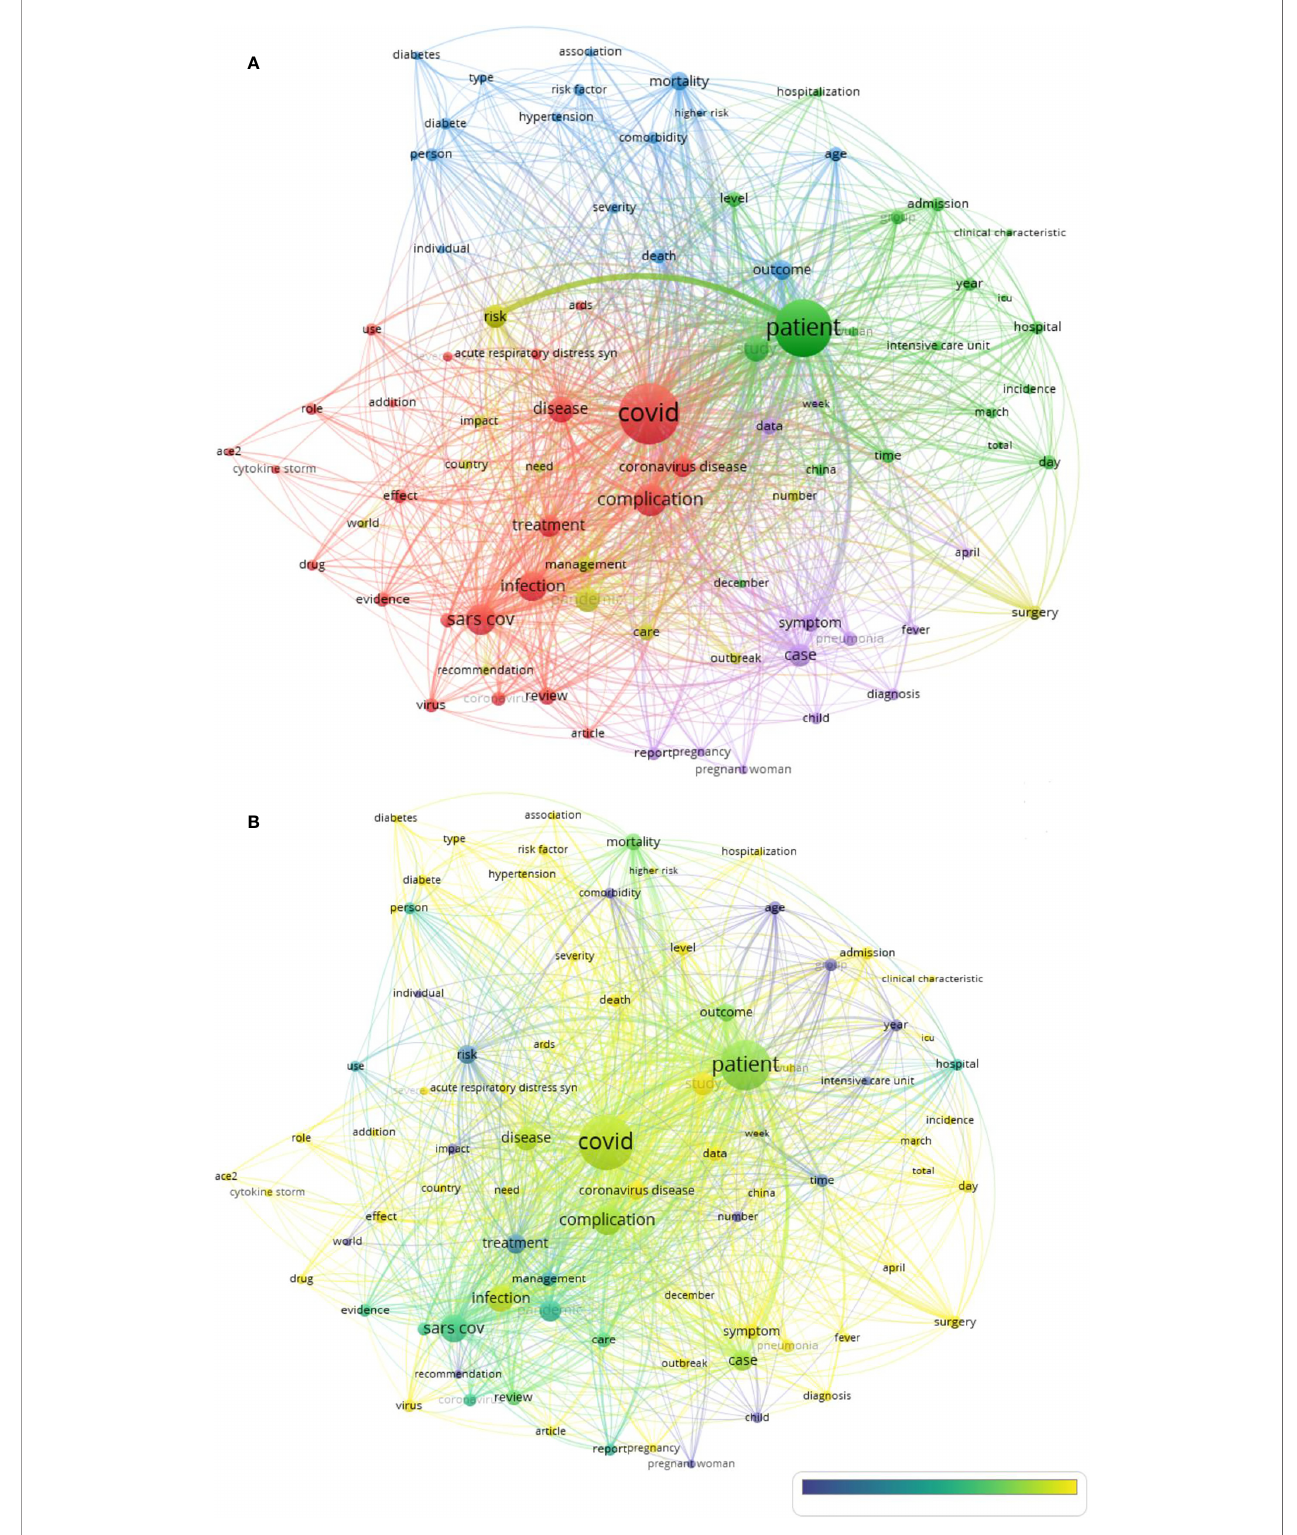
FIGURE 6 | Keywords in publications about COVID-19 complication and sequelae research. (A) Mapping of the keywords into seven clusters with different colors. (B) Distribution of keywords was presented according to the appearance for the average